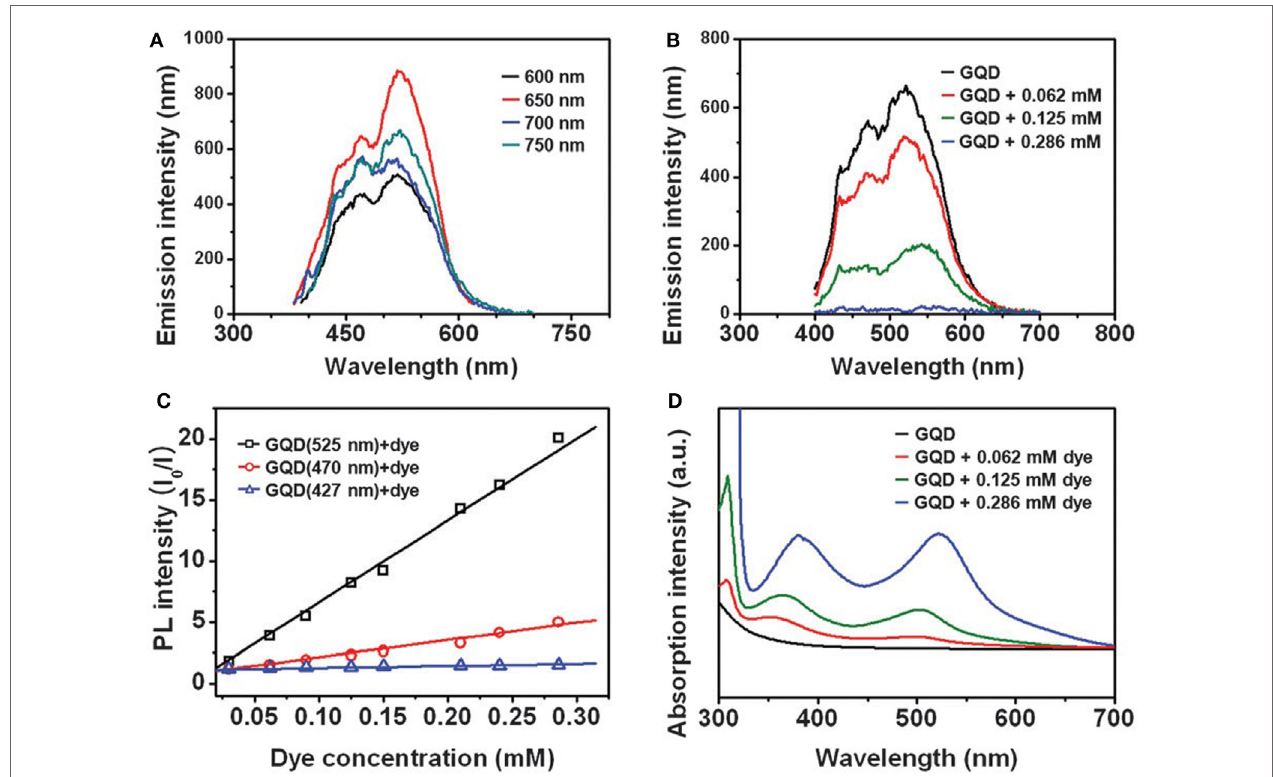
FiGURe 10 | (A) Upconverted PL spectra of the GQDs at different excitation wavelengths. (B) Fluorescence spectra of GQDs as a function of the amount of dye molecules from 62 to 286 μ M. (C) Stern–Volmer plots of the fluorescence quenching of GQDs with the N719 dye. (D) Absorption spectra of GQDs as a function of the amount of dye molecules from 62 to 286 μ M (Lee et al., 2013a). Copyright RSC Publishing, 2013.